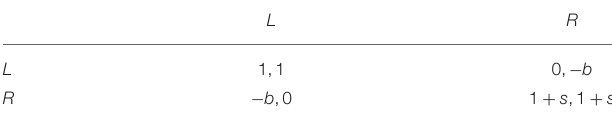
of attraction. Section 4 shows bifurcation diagrams, in section 4.1